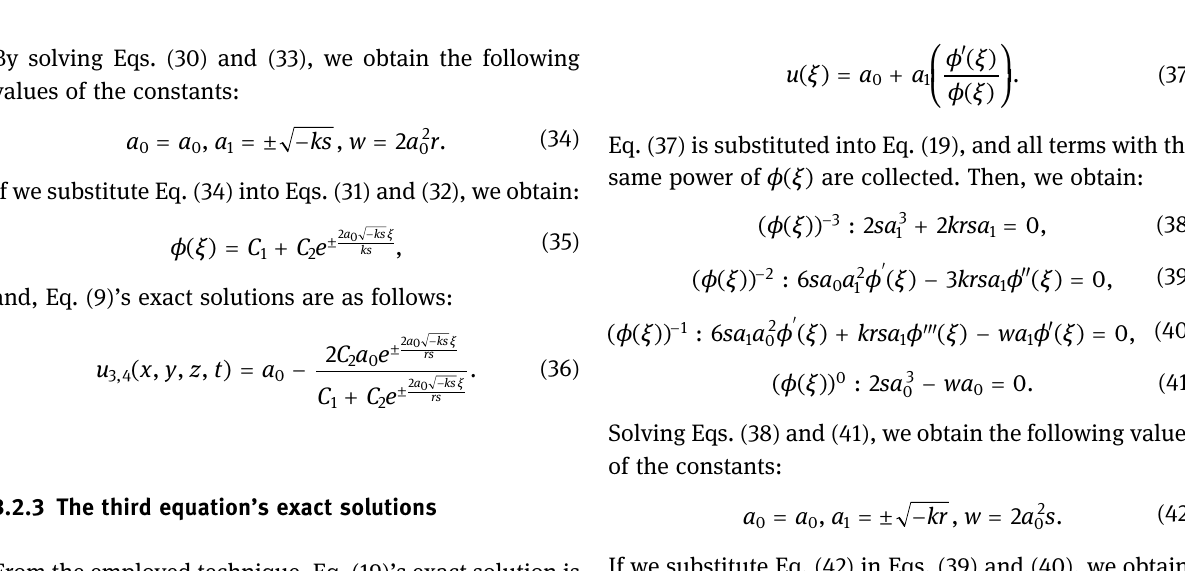
Figure 2: Graphical representations of ( a ) and ( b ) when y . ( a ) 3D representation, ( b ) contour representation, and ( c ) 2D